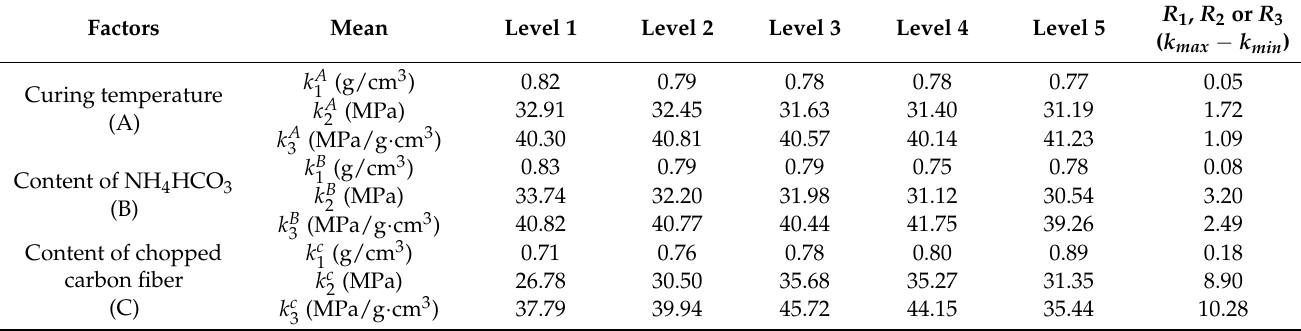
Table 3. Values of k and R of LCGFR-LDUPR composite